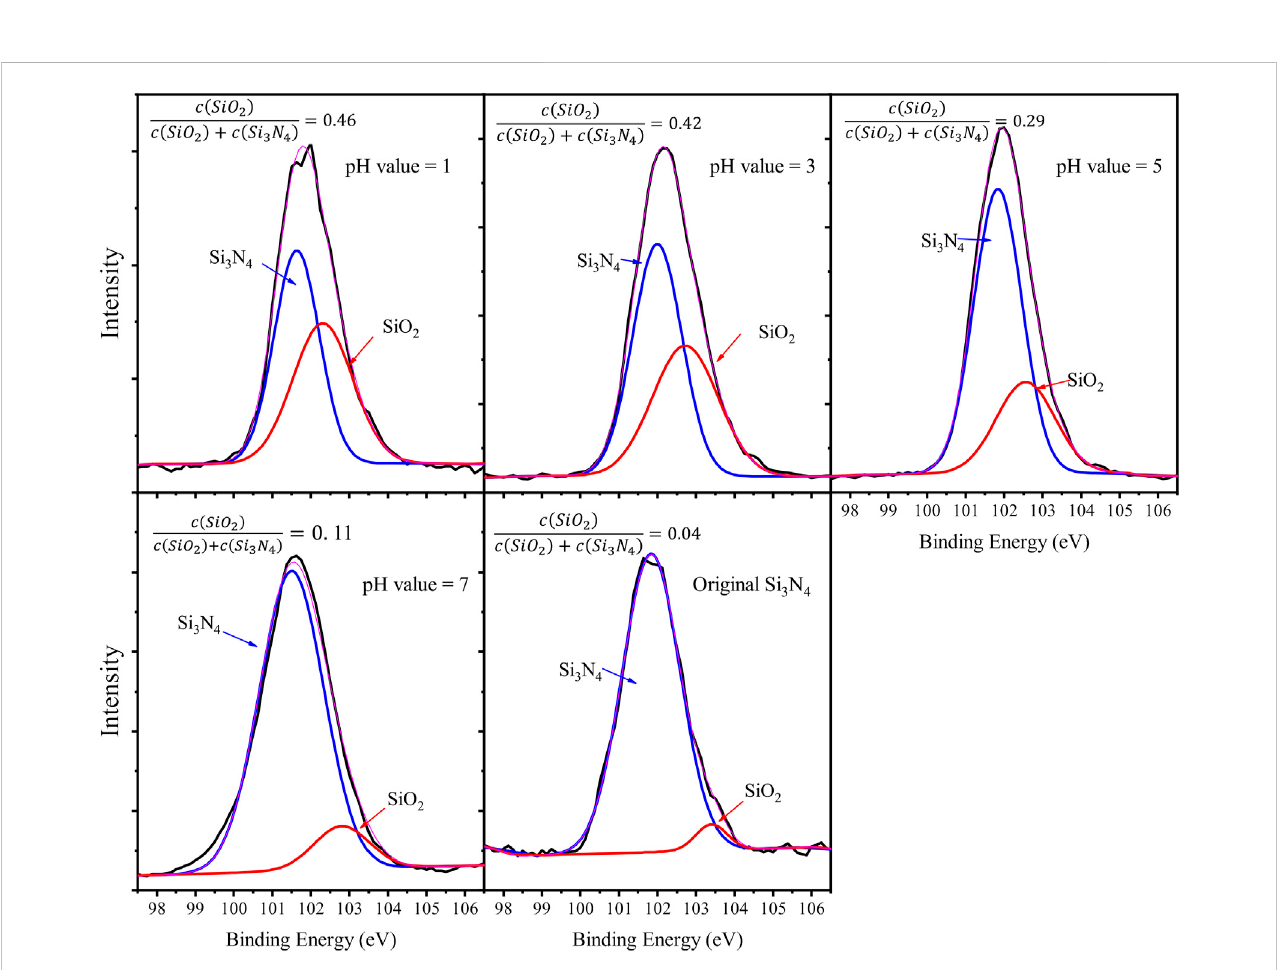
FIGURE 8 XPS results of Si 2p of wear scars on Si 3 N 4 balls (left four images) after running-in in different pH values and the original Si 3 N 4 ball